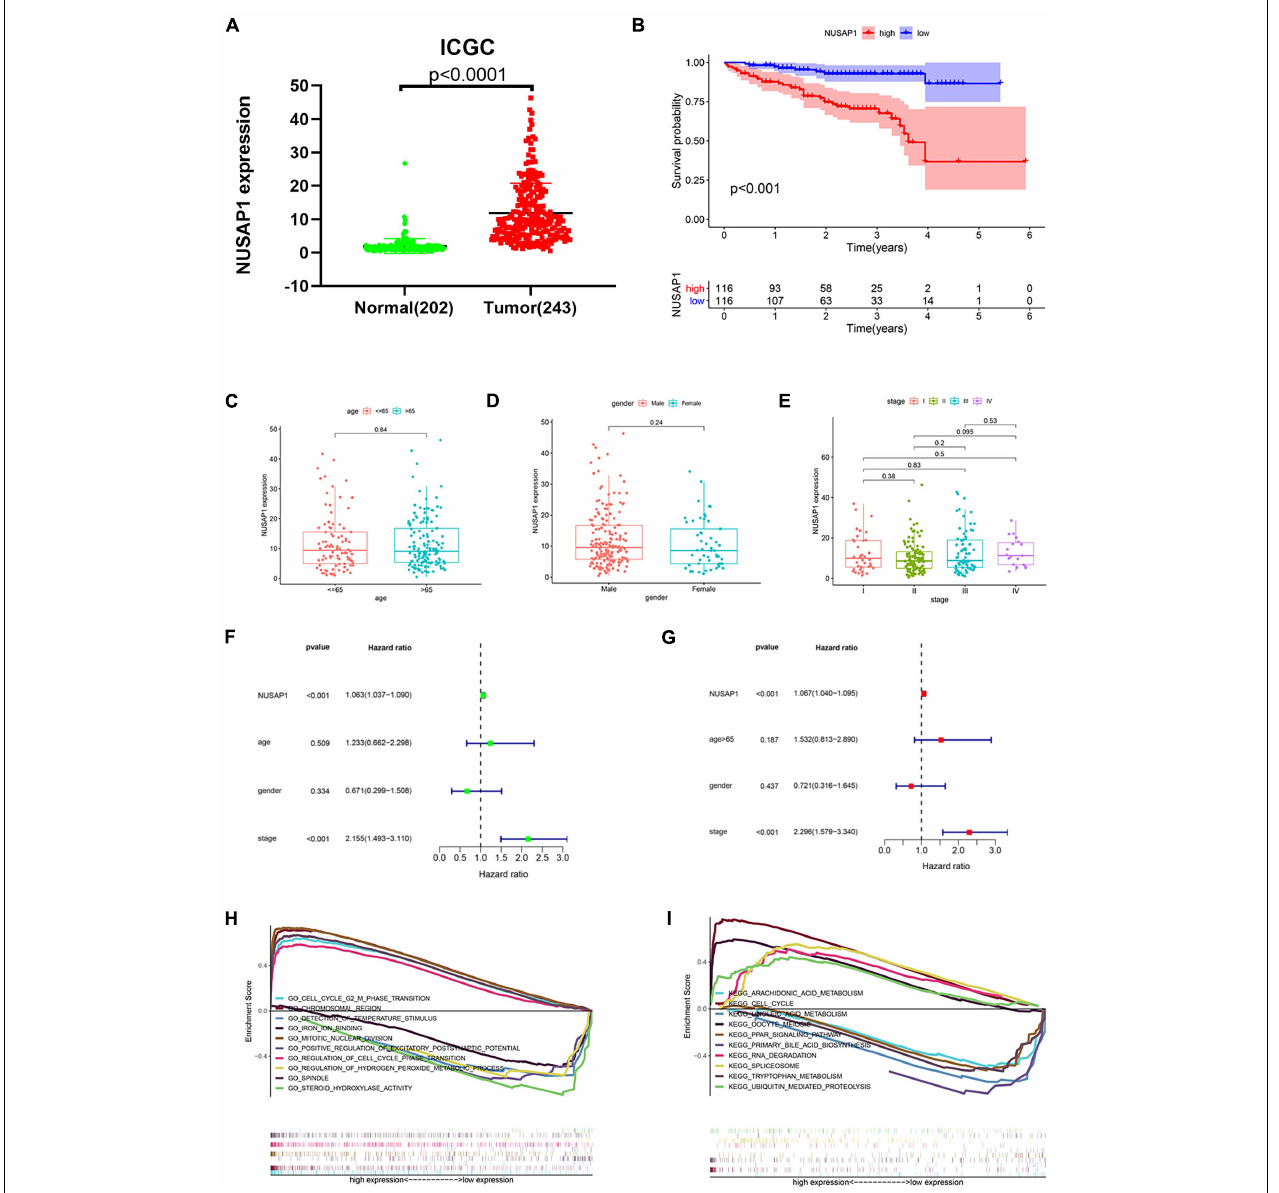
FIGURE 4 | Dot plot, Kaplan–Meier curve, box plots, forest plots, and GSEA enrichment analysis. All pictures were made by HCC patients’ expression and clinical information in ICGC database. (A) Dot plot of NUSAP1 expression in normal samples and HCC samples. (B) Kaplan–Meier curve of OS analyzed between high NUSAP1 expression group and low expression group. (C) Bar graph of NUSAP1 expression in different age groups. (D) Bar graph of NUSAP1 expression in female and male. (E) Bar graph of NUSAP1 expression in different stage groups. (F) Univariate regression analysis. (G) Multivariate regression analysis. (H) GSEA enrichment analysis, which was based on GO gene sets. (I) GSEA enrichment analysis, which was based on KEGG gene